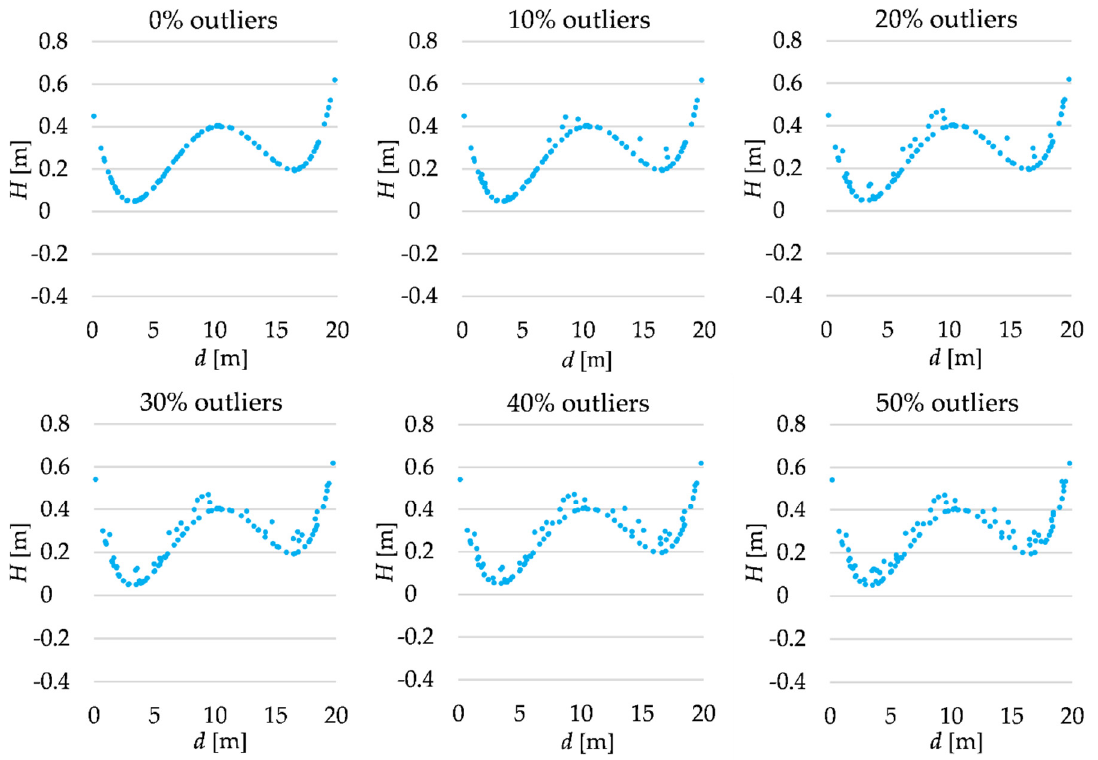
Figure 3. Simulated observation set (fourth-degree polynomial).